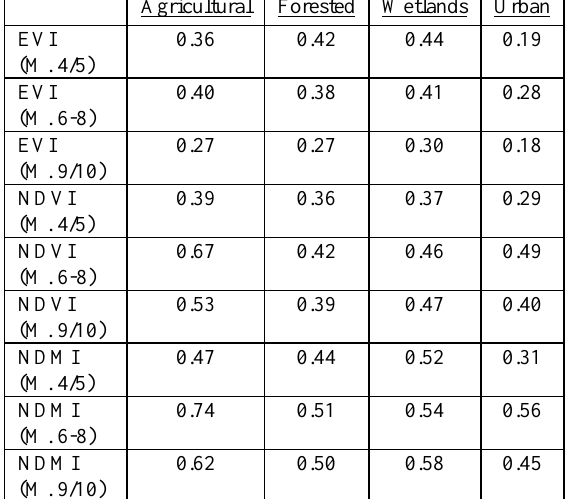
Table 3 . The results from a correlation analysis with each of the indices. The summary statistics are similar to Figure 9 with only the inclusion of mean values from each set of months